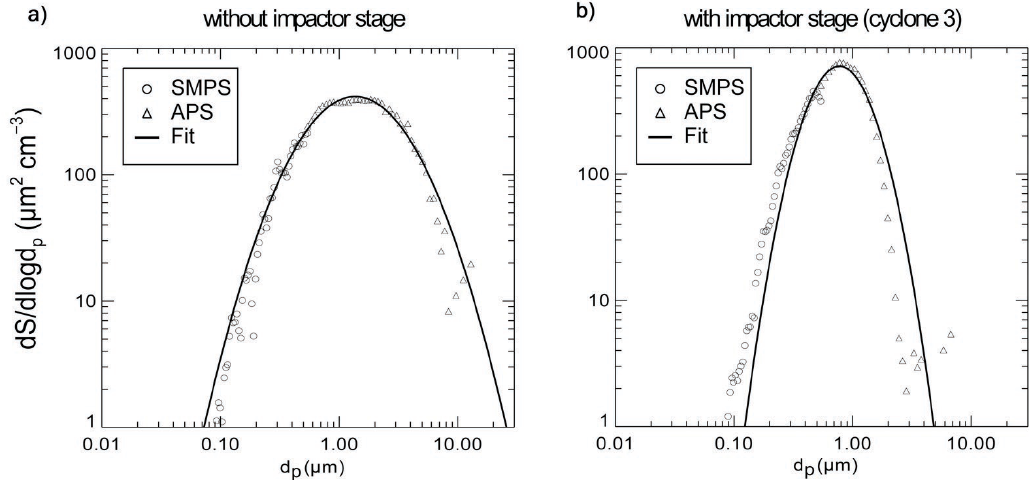
Fig. 3. Aerosol surface distributions of volcanic ash particles: comparison between distributions as obtained without (a) and with (b) using an impactor (cyclone 3) – aerosol surface distributions are calculated from number size distributions as measured by APS and SMPS (a) d med , surf = 1 . 36 µm; σ surf = 2 . 33 (exp. IN14 100) (b) d med , surf = 0 . 77 µm; σ surf = 1 . 66 (exp. IN14